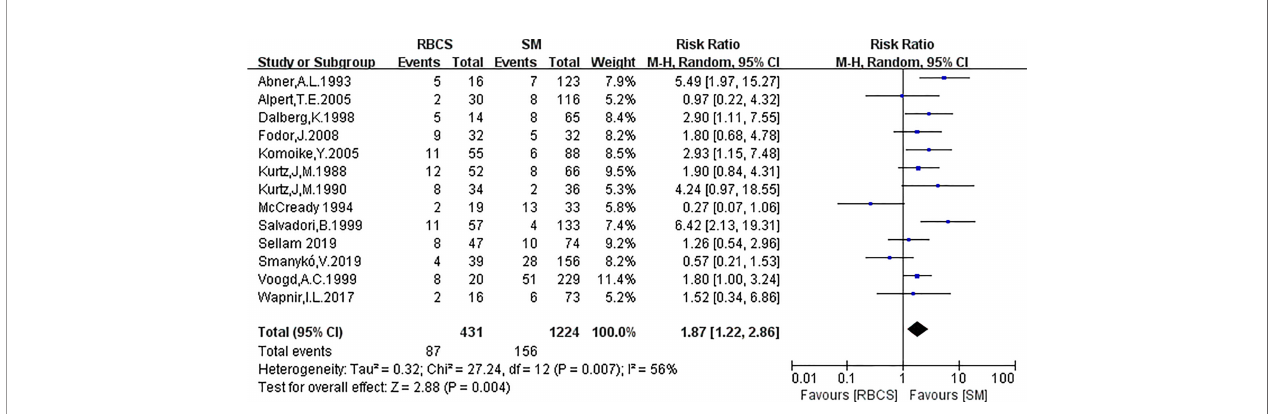
FIGURE 2 | Forest plot of repeated breast-conserving surgery (RBCS) versus salvage mastectomy (SM) after ipsilateral breast tumor recurrence (IBTR), comparing secondary local recurrence rate (SLRR). The meta-analysis was performed with random effects model. RR more than 1 means the results favor SM